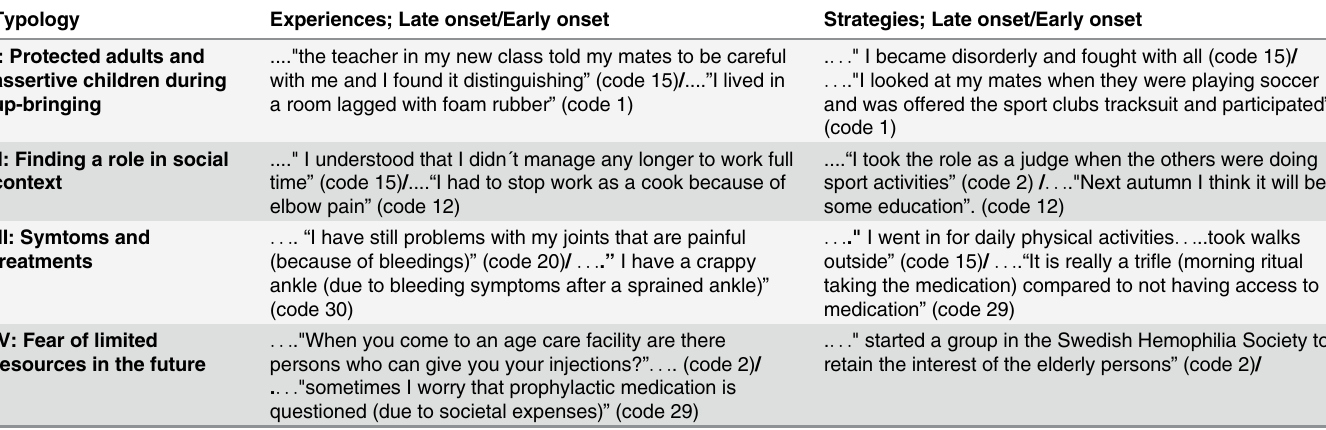
Table 4. Summery of